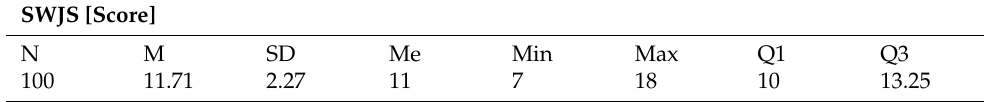
Table 3. The analysis of the SWJS results.